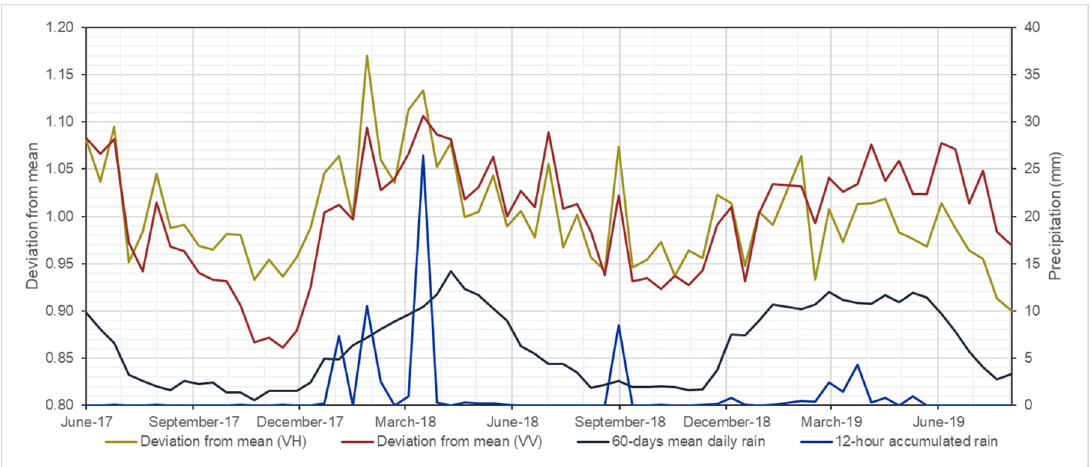
Figure 4. Example of the relationship between the deviation of the backscatter signal from the three-year average and the short-term (12-h) and long-term (60 days) accumulated precipitation at the time of the image acquisition. Mean backscattering data extracted from Sentinel-1 IW-GRD images over a 5-km square of invariant forest patch in Portel (Brazil). Rainfall data computed from IMERG data.